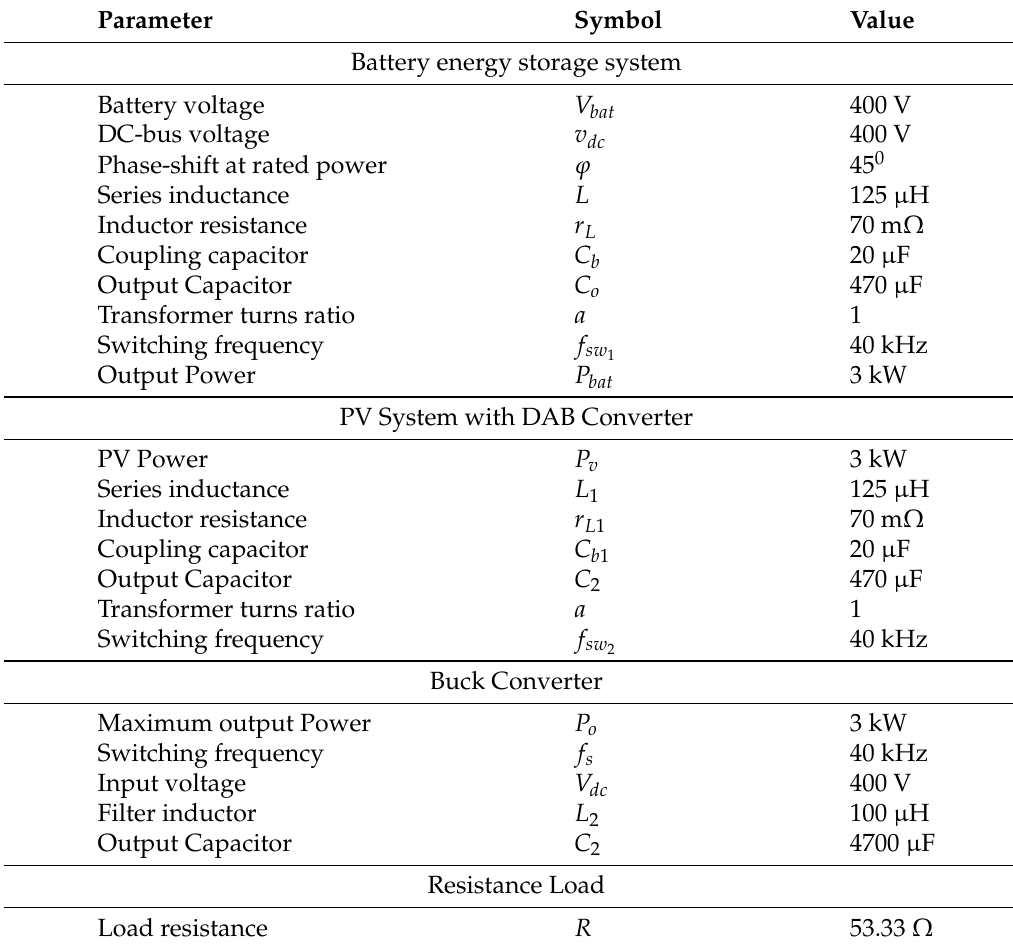
Table 2. Microgrid